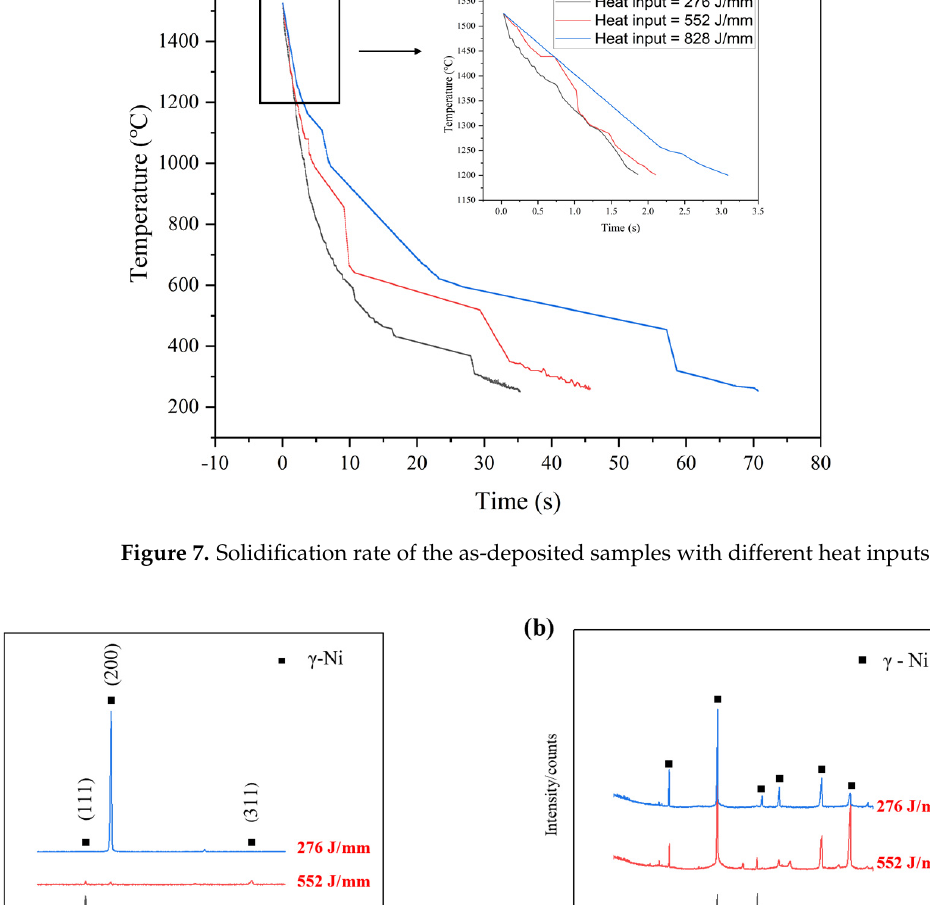
Figure 8. XRD and synchrotron XRD analysis of the as-deposited sample with 828 J/mm heat input: ( a ) XRD pattern and ( b ) synchrotron XRD pattern.